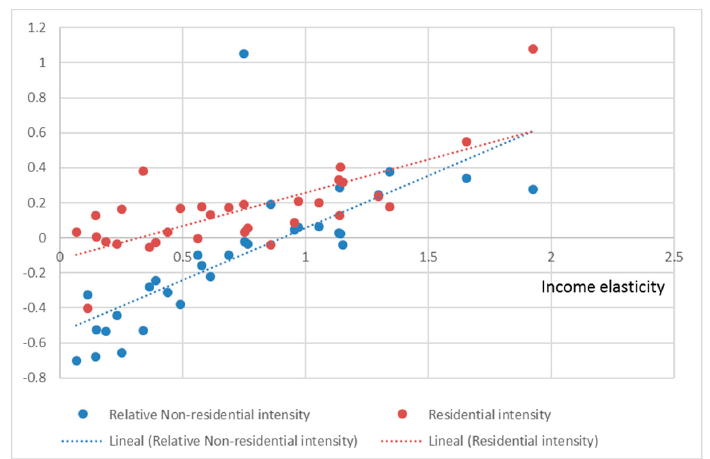
Figure 6. Income elasticity of electricity consumption versus intensities. Source: Own calculations with Eurostat data.